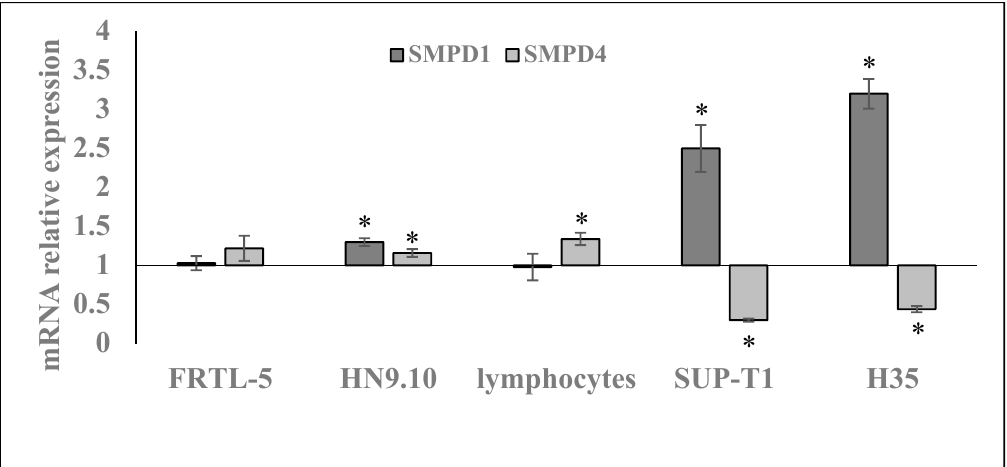
Figure 6. Effect of gentamicin on SMPD1, SMPD4 gene expression in thyrocytes (FRTL-5 cells), embryonic hippocampal cells (HN9.10), human lymphocytes and non-Hodgkin’s T cell human lymphoblastic lymphoma cells (SUP-T1), hepatoma cells (H35), and human gastric cancer cells (NCI-N87). GAPDH expression was used as a housekeeping gene. RT-PCR analysis was performed in control and experimental cells collected after 24 h after 1.5mM GM treatment. Data are expressed as the mean ± SD of three independent experiments performed in three PCR replicates (significance, * p < 0.001 versus control sample).